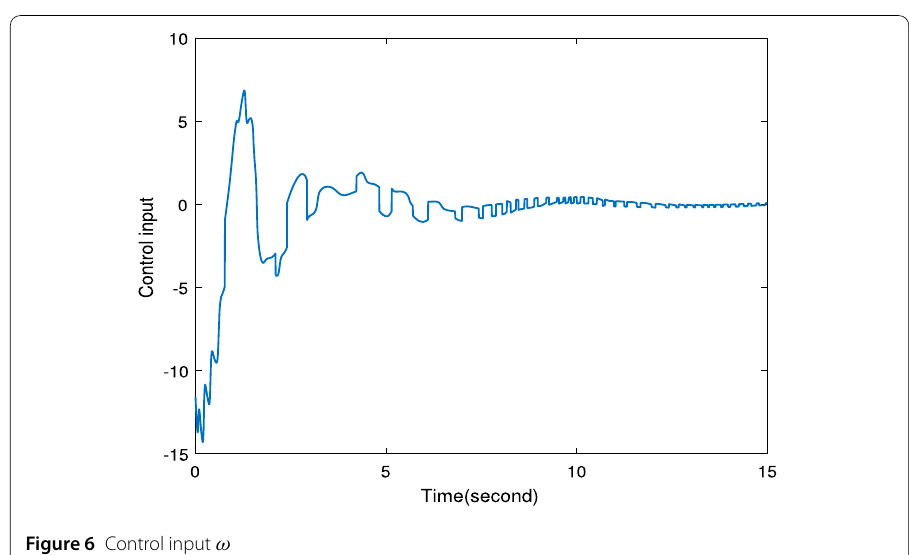
Figure 6 Control input